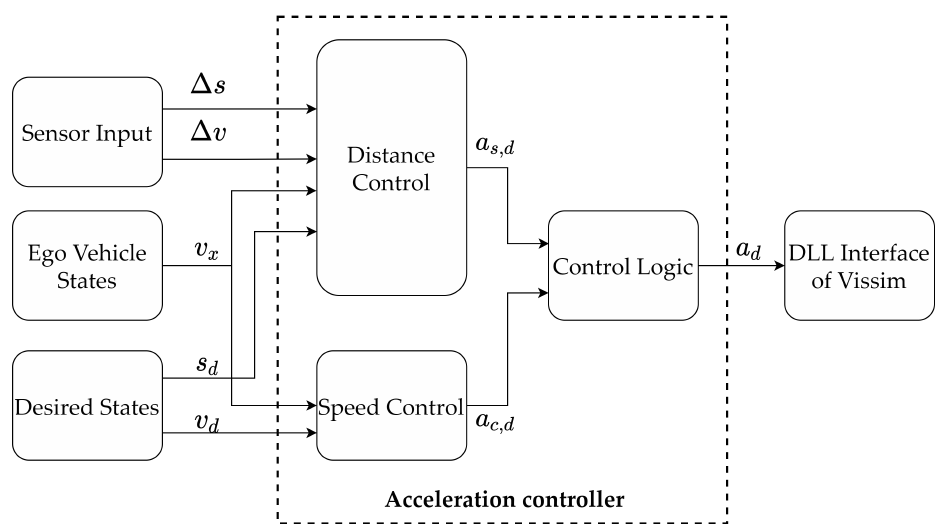
Figure 4. Longitudinal control schema in the driving model.